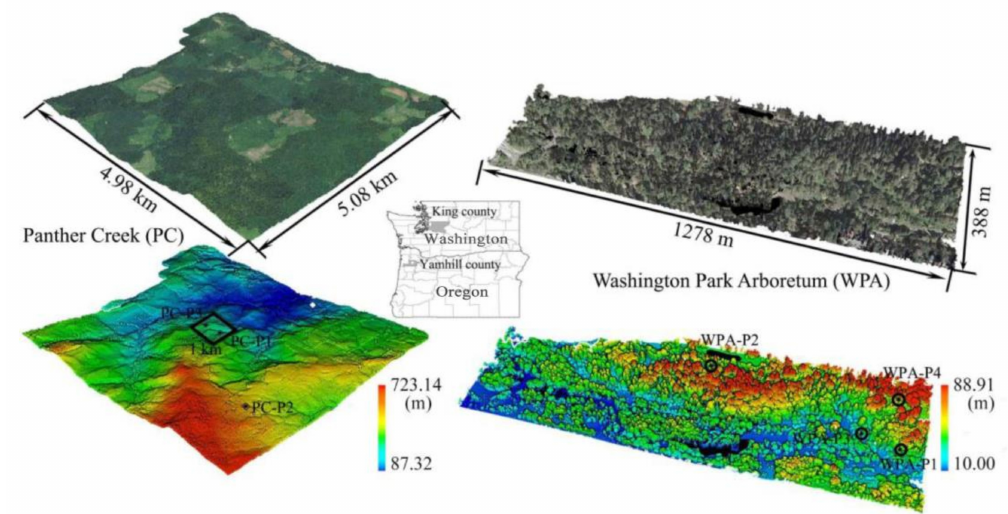
Figure 1. The original aerial laser scanning (ALS) colored by height and corresponding ALS data overlaid with true-color aerial photos in the urban heterogeneous forest of Washington Park Arboretum (WPA) in Washington state, USA, and natural homogeneous forest of Panther Creek (PC) site in Oregon state, USA. Seven forest plots in total (i.e., WPA-P1, WPA-P2, WPA-P3, WPA-P4, PC-P1, PC-P2, and PC-P3) were set up in these two study